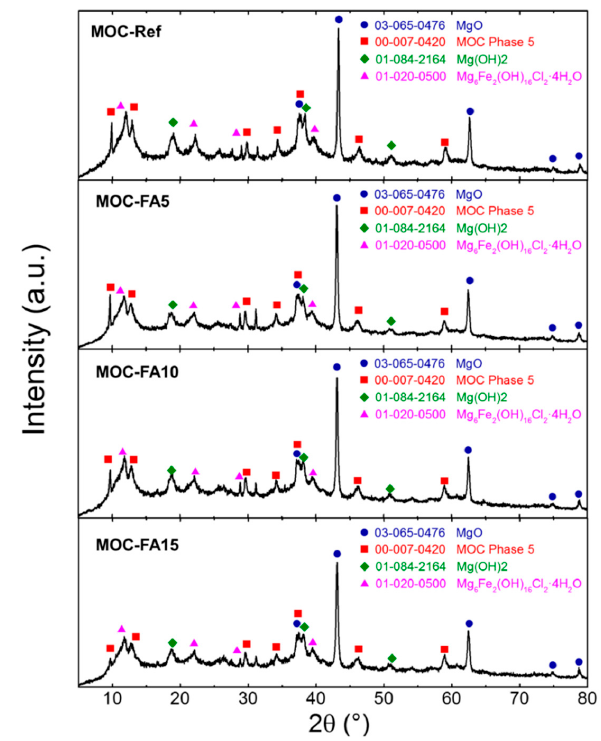
Figure 4. XRD. X-Ray diffraction pattern for pastes MOC-Ref, MOC-FA5, MOC-FA10, and MOC- Figure 4. XRD. X-ray di ff raction pattern for pastes MOC-Ref, MOC-FA5, MOC-FA10, and FA15.